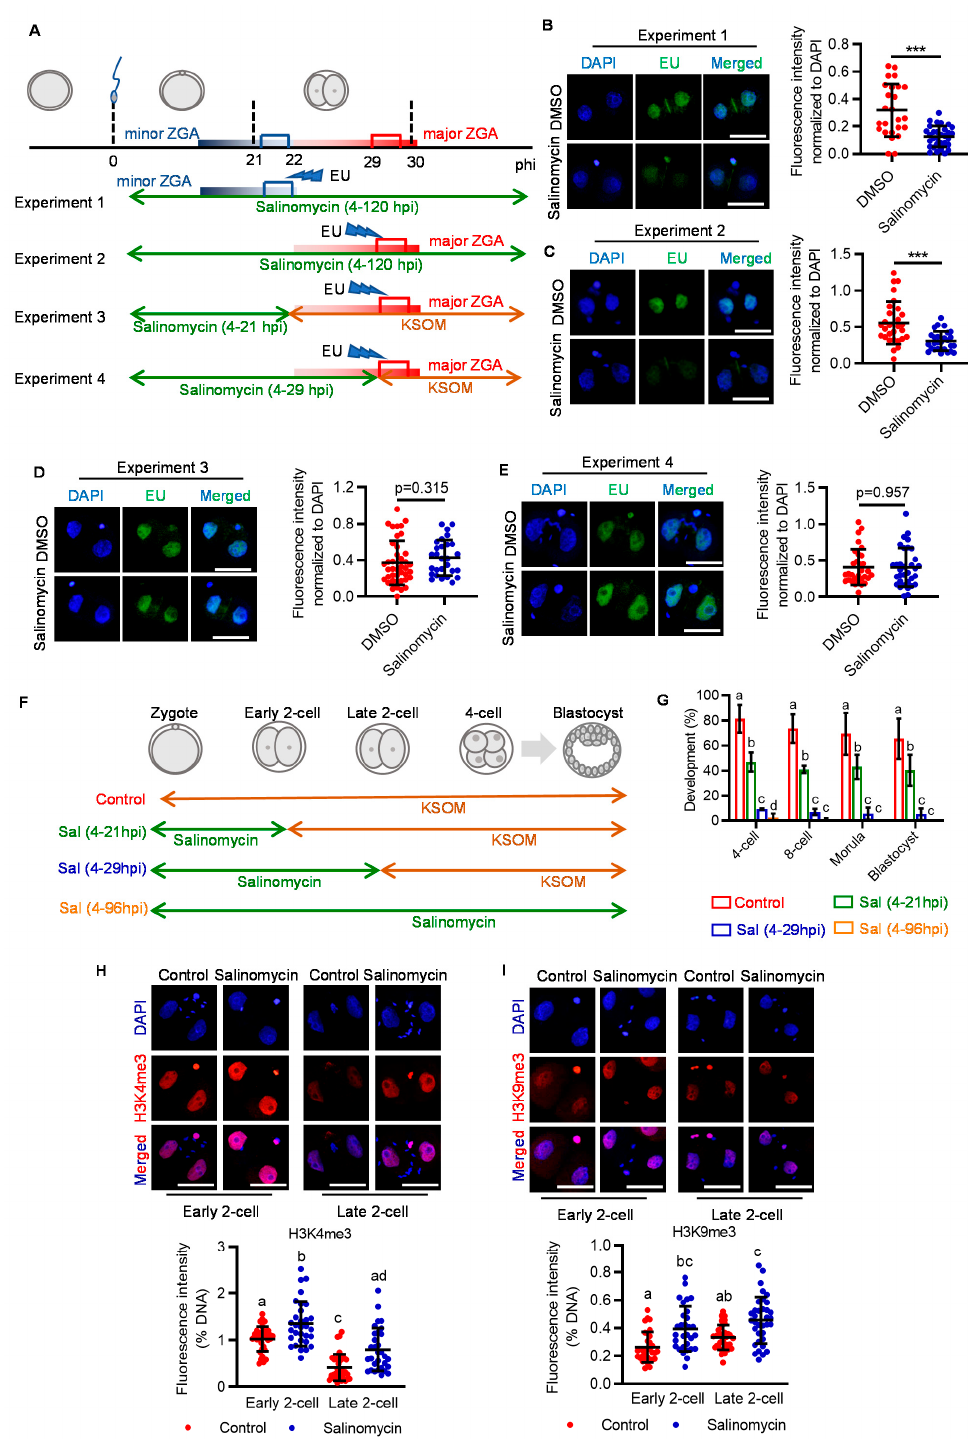
Figure 2. Inhibition of LRP6 impairs ZGA. ( A ) Experimental design of EU incorporation in salinomycin-treated embryos at various periods. ( B – E ) Representative images of EU staining